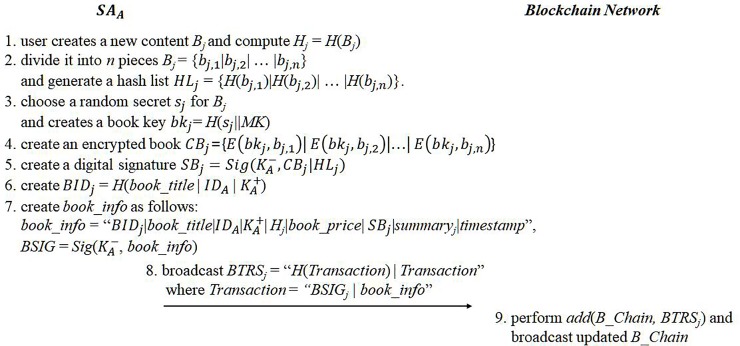
eBook registration.